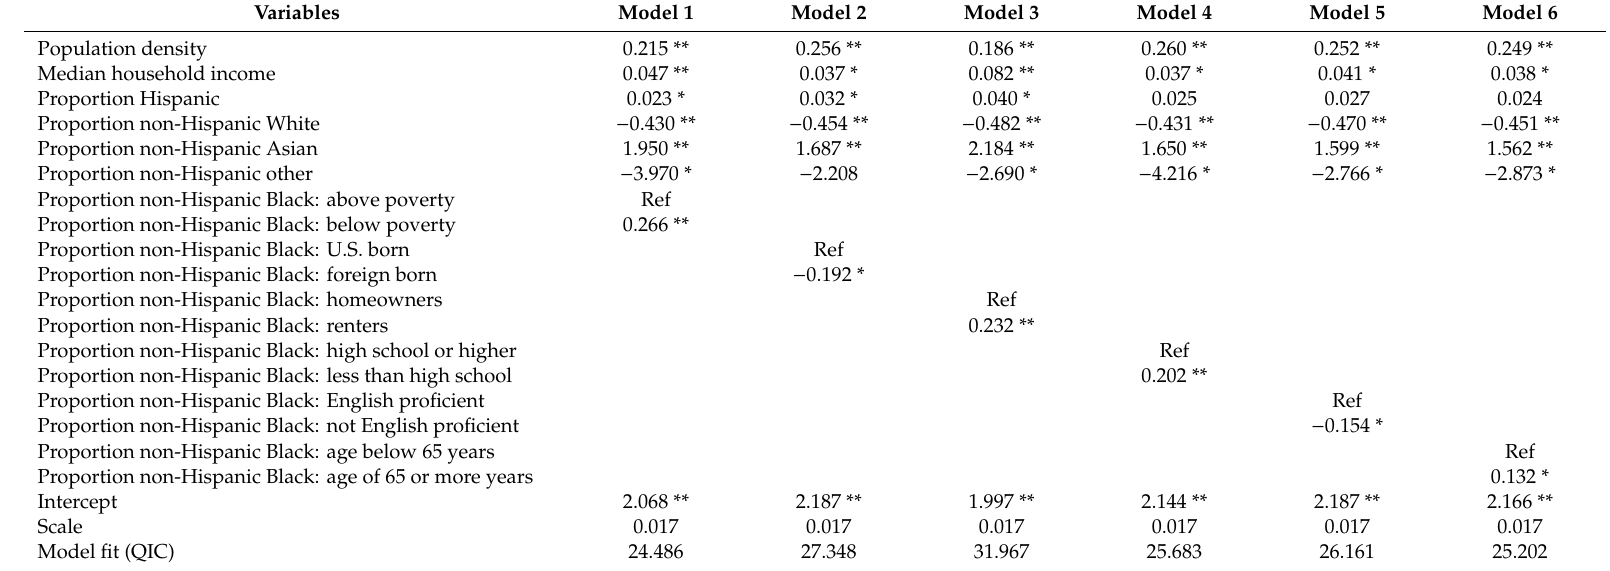
Table 5. Intra-categorical GEE analysis for the non-Hispanic Black population: Beta coe ffi